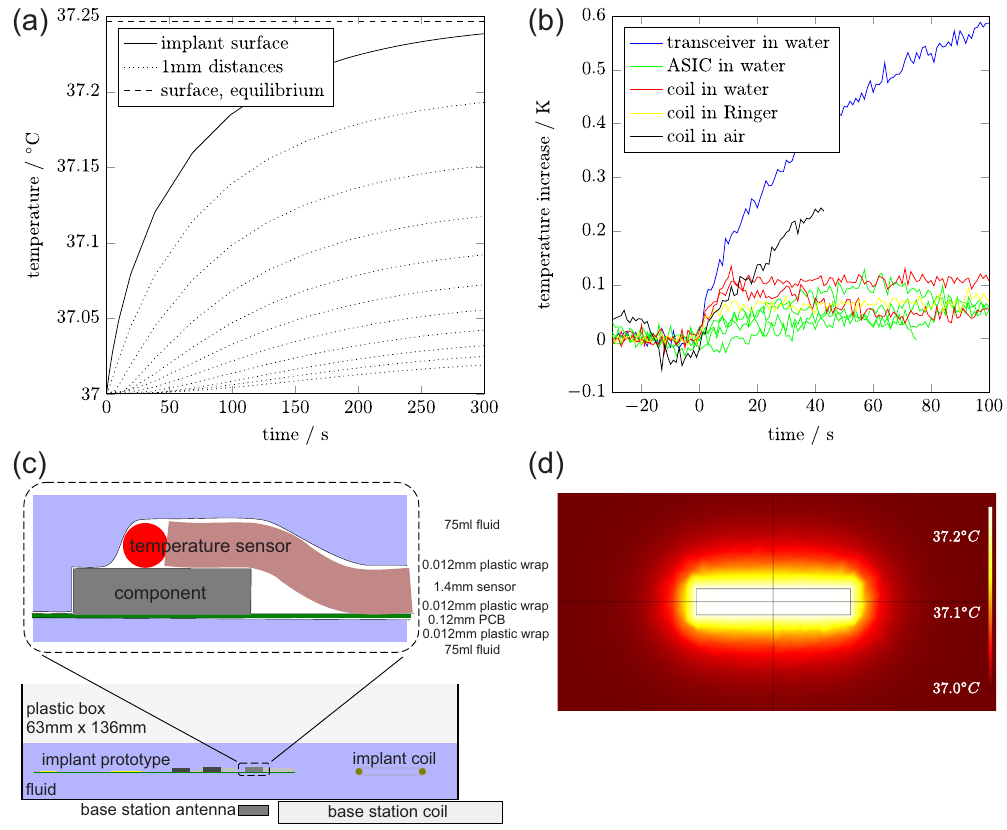
Figure 7. ( a ) simulated heat-up; ( b ) measured temperature increase after power on; ( c ) measurement setup for testing the heating up of the implant; ( d ) temperature distribution after 300 s, calculated with a simple FEM (Finite element method) model (COMSOL (Berlin, Germany)). Rectangle shows the 24 mm × 4 mm implant cross section